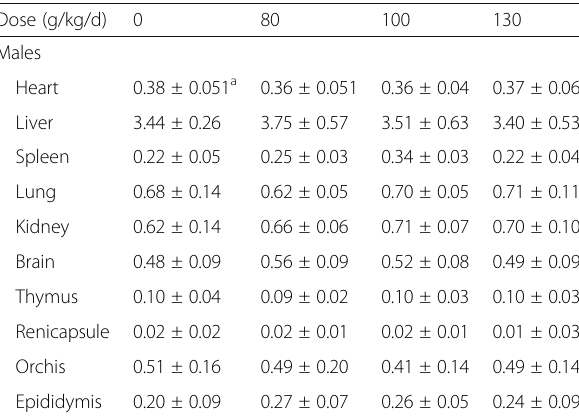
Table 10 Organ coefficient for male rats treated with JDHY granules for 13 weeks